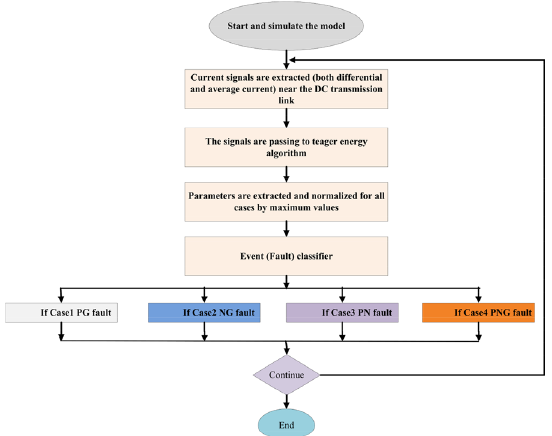
Fig. 15 Flow chart of the proposed working